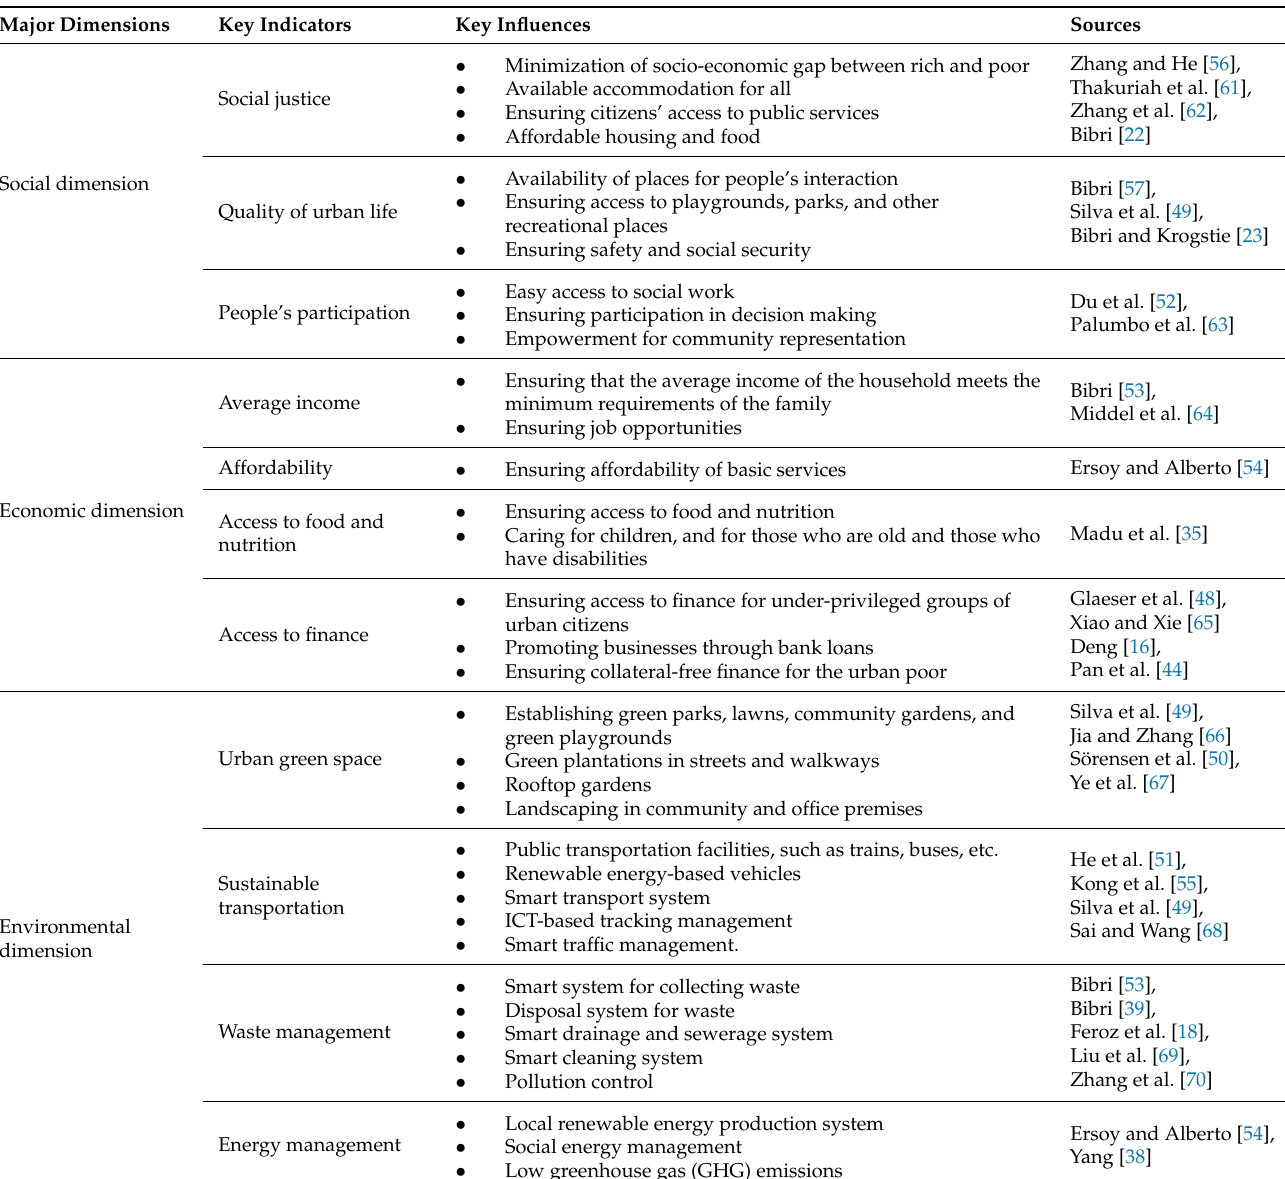
Table 4. Summary of relationships between urban management and urban